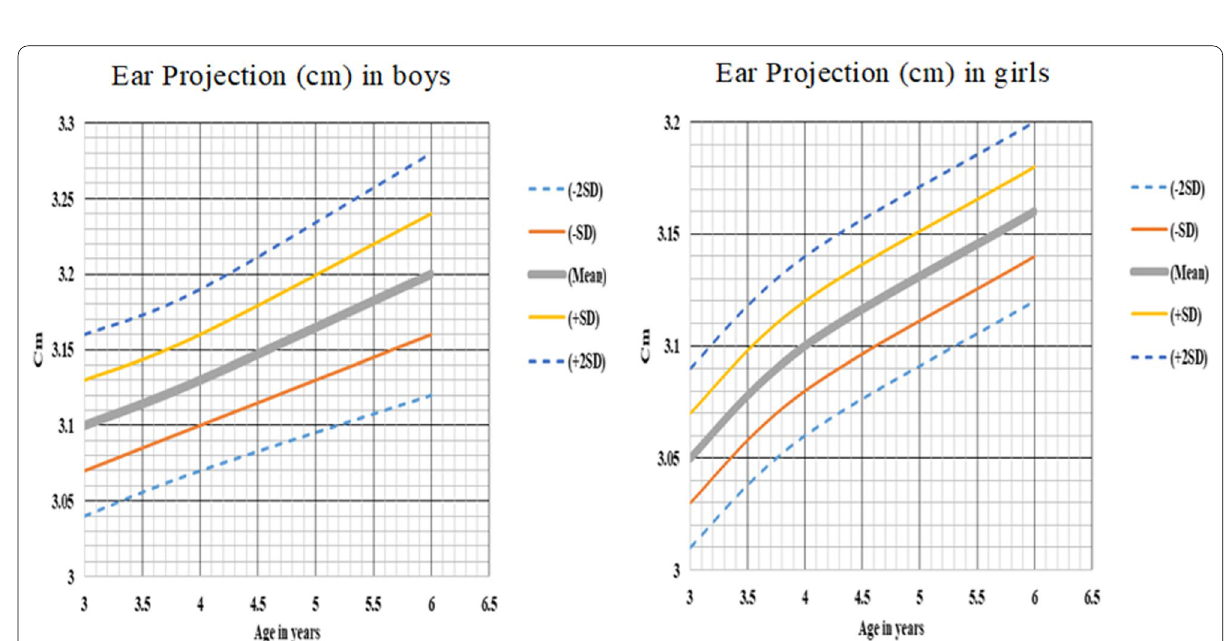
Fig. 13 Ear projection (cm) in boys and